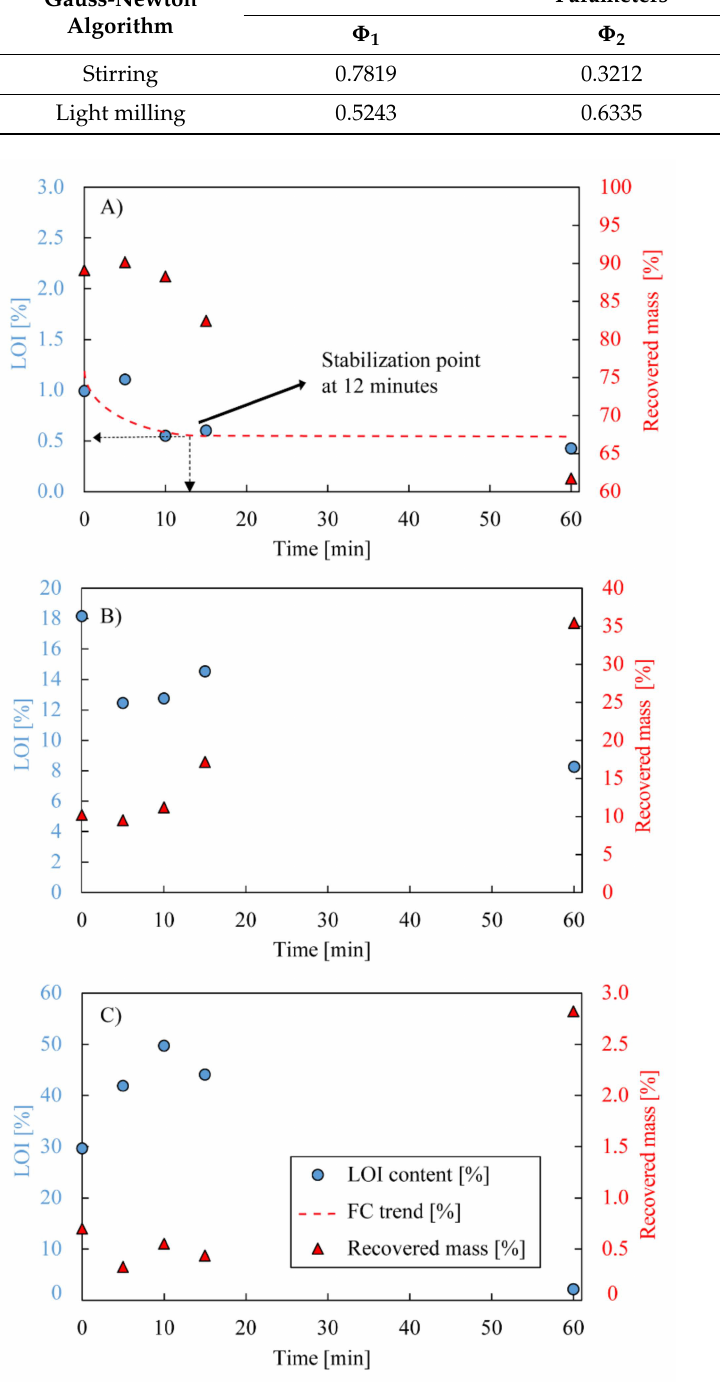
Figure 7. ( A ) Clean sand, ( B ) fines wasted material, ( C ) light wasted material. In general terms, the recovery of the clean sand is above 85% by mass, and LOI content achieved is below 1% from minute 5. According to Figure 6A, lengthening the stirring time does not lead at lower LOI values, thus representing an unnecessary action. Rejects (fine and light phases) represent approximately 12% by mass with relatively high LOI percentages (15% fine rejection and 30–40% sink